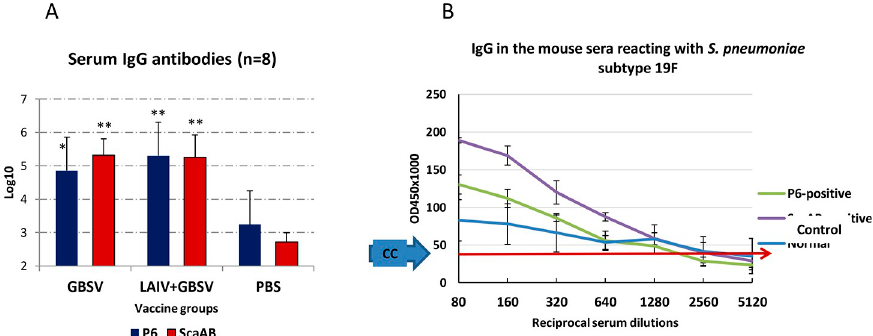
Fig 2. Immune response against GBS components or S . pneumoniae 19F serotype after intranasal immunization using GBSV or LAIV+GBSV. (A) serum IgG specific to GBS recombinant peptides P6 and ScaAB on day 42 after first vaccination (ELISA); � —P < 0.01, �� —P < 0.001 compared to PBS group. (B) plot of serial serum dilution reacting with precipitated S . pneumoniae serotype 19F (ELISA); each curve represents data from six tested sera; the arrow represents the control level obtained as mean OD 450 of 5–8 negative wells plus 3